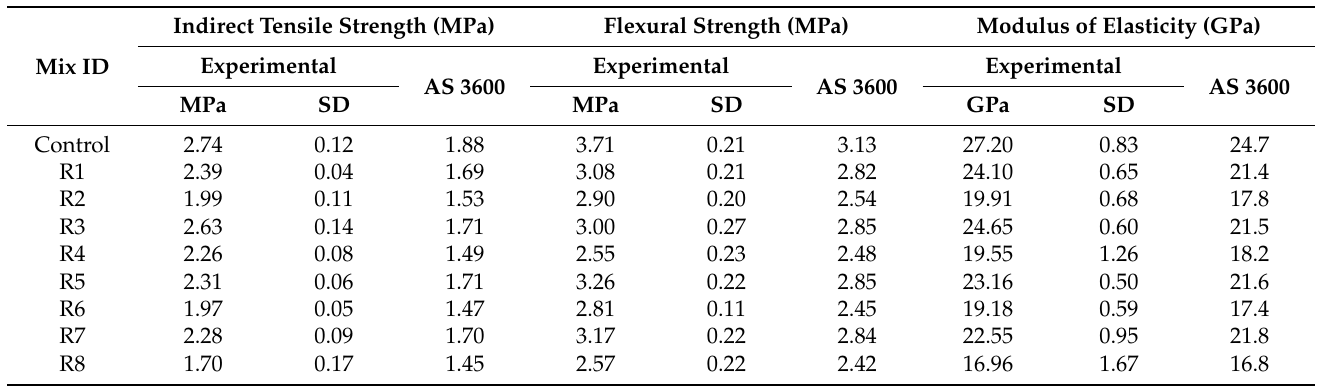
Table 4. Experimental and predicted values of indirect tensile and flexural strengths and modulus of elasticity. Indirect Tensile Strength (MPa) Flexural Strength (MPa) Modulus of Elasticity (GPa) Experimental Experimental Experimental Mix ID AS 3600 AS 3600 AS 3600 MPa SD MPa SD GPa SD